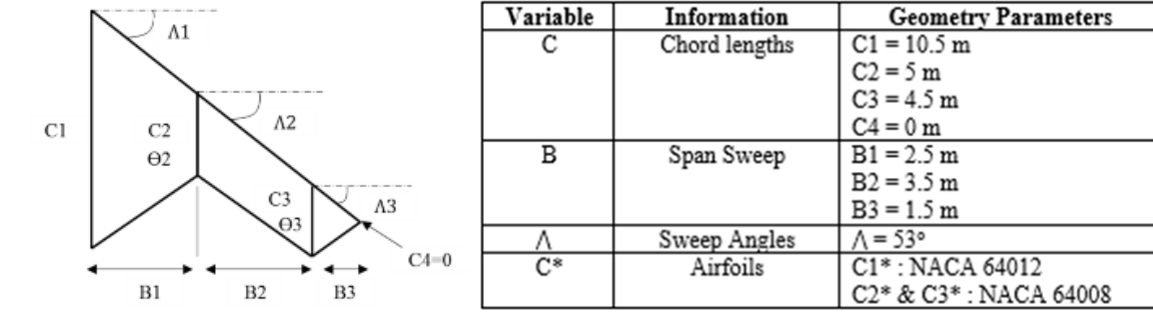
Figure 7. SACCON UCAV Geometry Parameterization